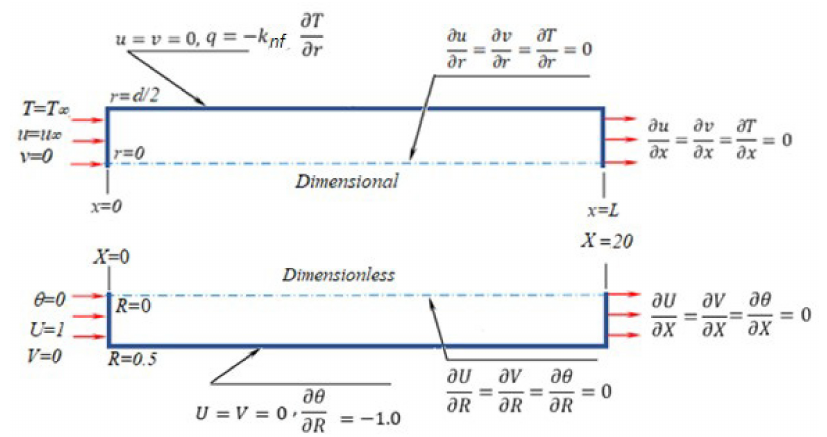
Figure 1. Schematic diagram in dimensional and dimensionless